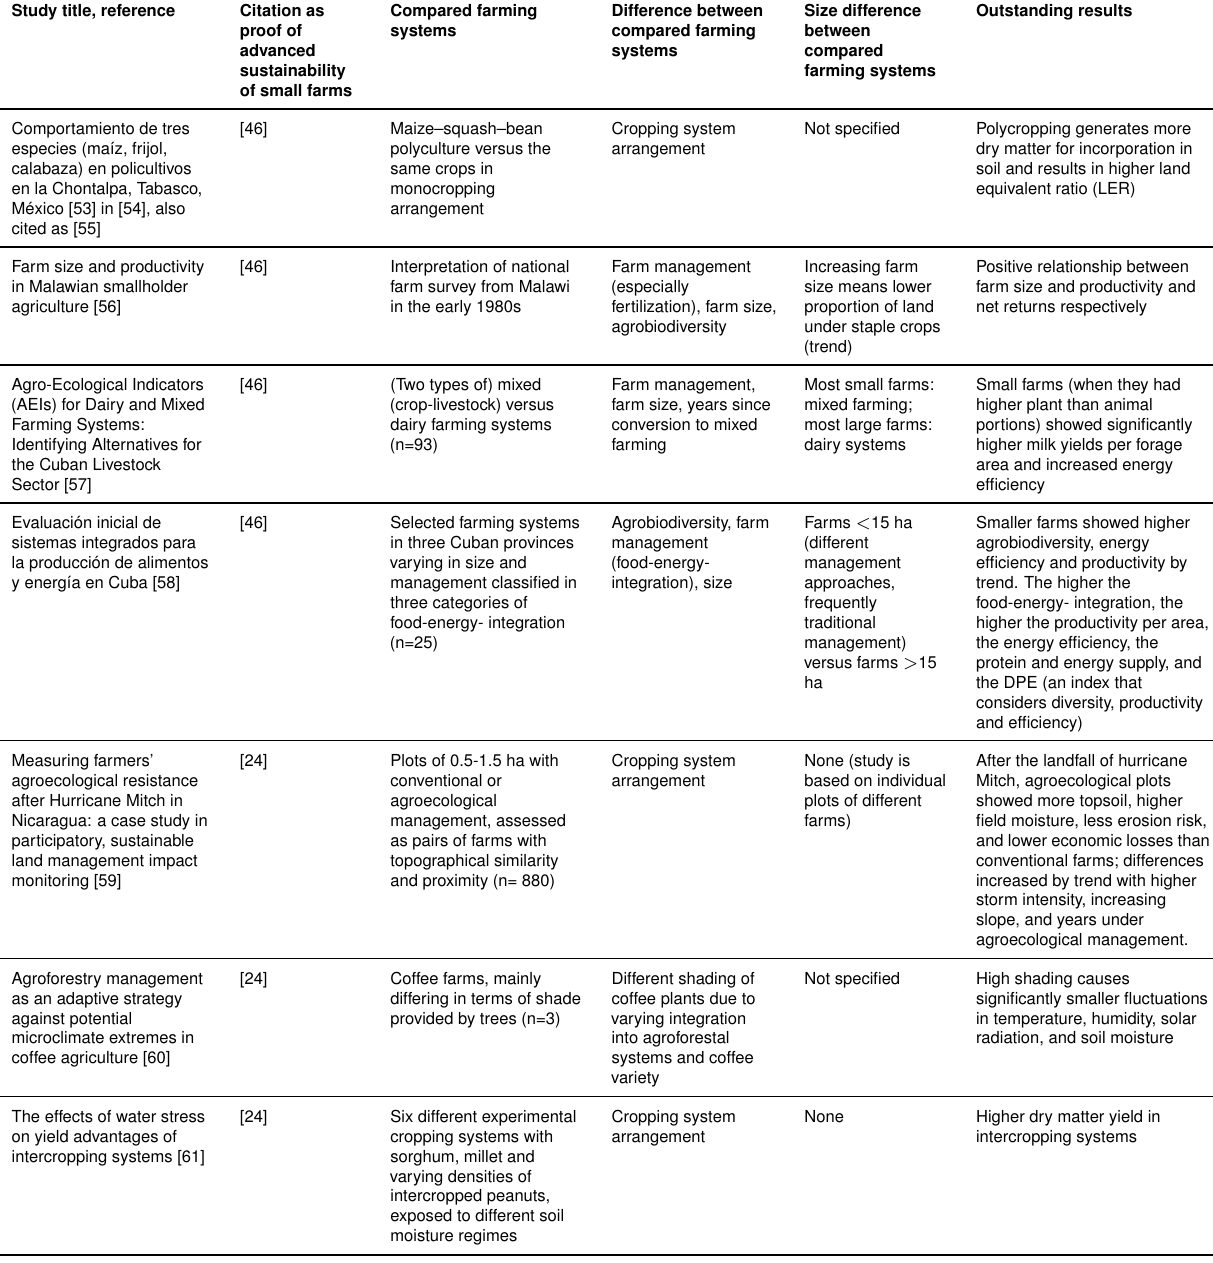
Table 1. Selection of studies cited in benchmark publications in agroecology to sustain the advanced sustainability of small